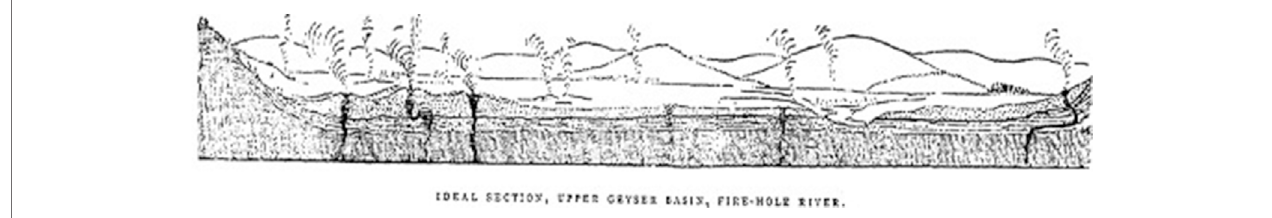
FIGURE 4 | Cross-section of the Upper Geyser Basin as presented in Dr. Hayden ’ s U.S.G.S. Report